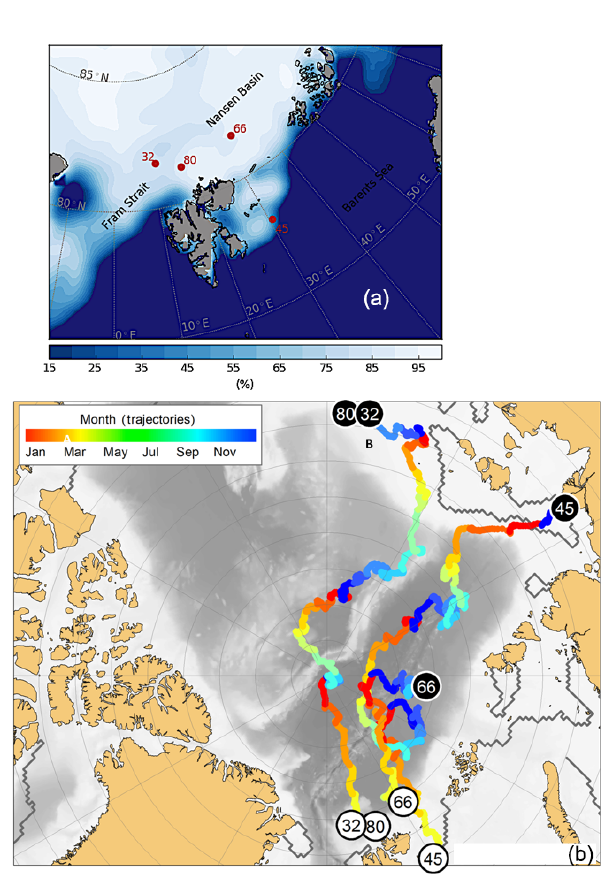
Figure 1. Study area with sample locations. (a) Sea ice coverage at the station and time of sampling in %. (b) Trajectories of the sea ice from which the cryogenic gypsum was released. Each trajectory starts where sea ice formed (black circles) and shows its drift until the time and place of sampling (white circles). The colour scale of the drift trajectories indicates the month in which the backtracked sea ice was at any given